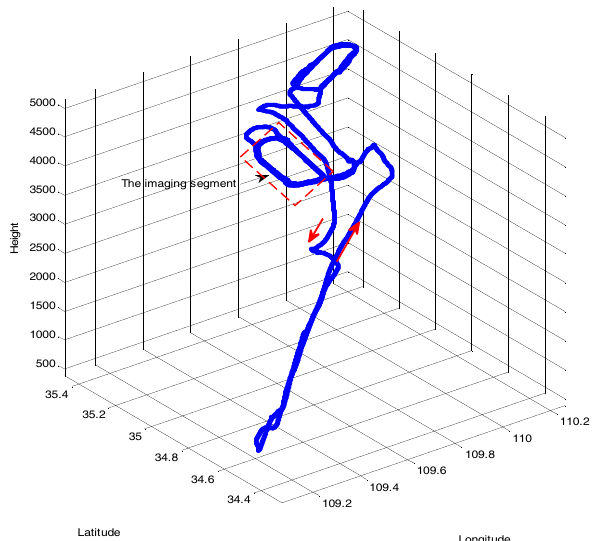
Figure 10. Flight trajectory.